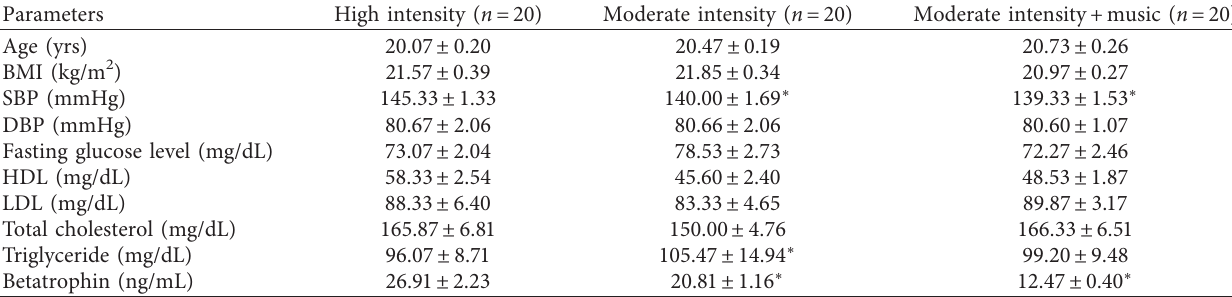
Table 1: Biochemical characteristics of the study population from different groups.